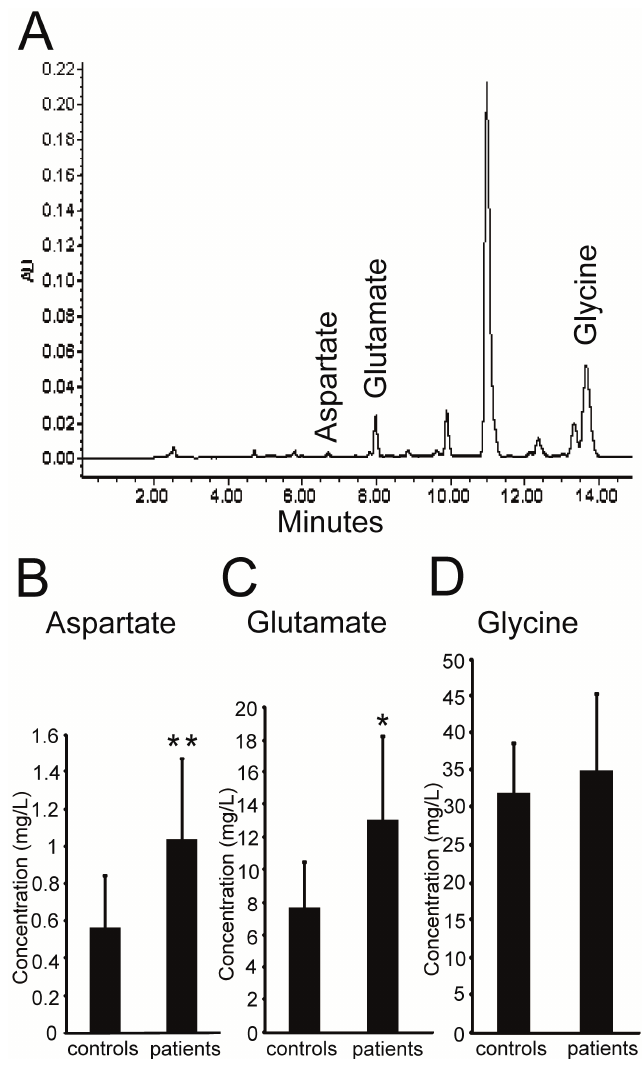
Figure 1. EAAs levels were higher in the plasma of PKC patients. ( A ) Representative HPLC chromatogram of three kinds of amino acids in the plasma; ( B , C ) The concentrations of aspartate and glutamate in the plasma from the PKC patient group ( n = 7) were higher than those of the healthy control group ( n = 12); ( D ) No significant difference was found in glycine levels between the two groups. Values are represented as mean ± SD, * p < 0.05; ** p <